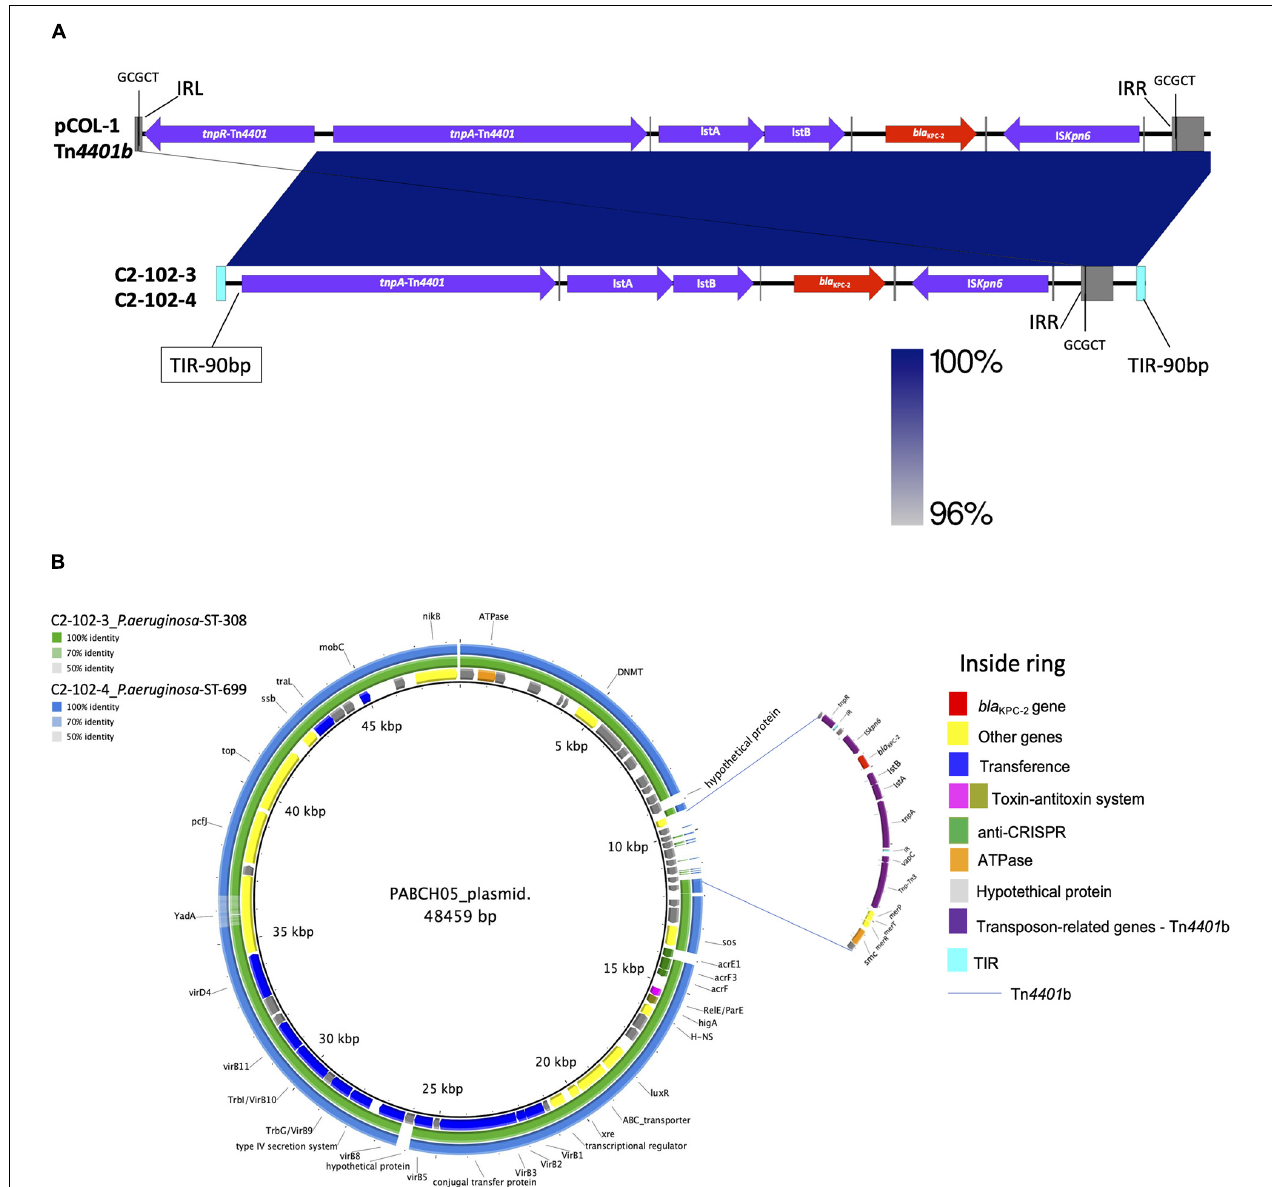
FIGURE 4 | (A) Comparison of Tn 4401 b containing bla KPC − 2 gene identified in two isolates of P. aeruginosa from the same patient (C2-102-3 and C2-102-4) with isoform Tn 4401 b from P. aeruginosa COL-1 from Colombia (accession number KC609323.1) (18) . Gray squares represent left and right inverted repeats (IRL and IRR, respectively) delimiting Tn4401b, flanked by GCGCT target site duplications (TSDs). Genes are denoted by horizontal arrows with their corresponding transcription orientations. Insertion sequences: Isk pn6 and Isk pn7 with IRL and IRR sequences (gray line); transposase tnpA and resolvase, tnpR . (B) BLAST Ring Image Generator (BRIG 0.95 and BLASTN v2.2.29) of comparison of the annotated plasmid from P. aeruginosa PABCH05 strain, Boston, MA, United States (accession number CP056099.1), with C2-102-3 and C2-102-4 isolates sequenced in this study. The internal ring shows the resistance and structural genes of the plasmid of the PABCH05 strain indicated by different colors (right panel). Green ring and blue ring correspond to the BLASTn result of C2-102-3 and C2-102-4 contigs relative to the plasmid reference (inside ring), respectively. The Tn 4401 b without the resolvase (tnpR) gene and surrounding is indicated by the blue lines. The transposon is flanked at both ends by terminal inverted repeats (TIRs) of 90 bp followed downstream by tnpR and upstream by vapC - tnpA - merP - merT - merR